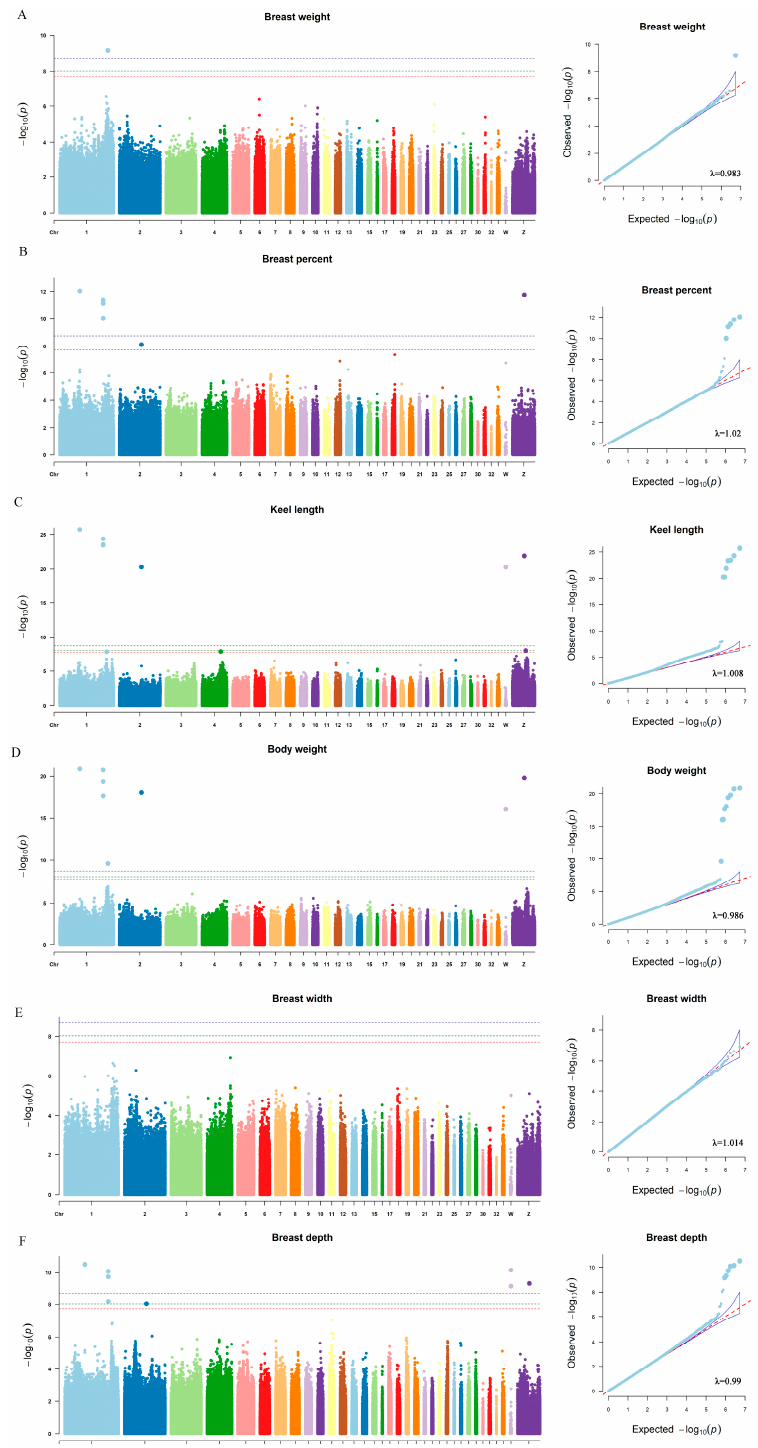
Figure 4. The Manhattan plot and Q–Q plot for breast weight and other traits. In the Manhattan plot, the X axis represents the position of SNPs in chromosome and the Y axis represents the − log 10 ( p -value); The red dashed line represents a 10% genome-wide significance level ( p = 1.79 × 10 − 8 ) after the Bonferroni correction; the green dashed line represents a 5% genome-wide significance level ( p = 8.96 × 10 − 9 ) after the Bonferroni correction; and the blue dashed line represents a 1% genome-wide significance level ( p = 1.79 × 10 − 9 ) after the Bonferroni correction. ( A ) Breast muscle weight; ( B ) Breast muscle percent; ( C ) Keel length; ( D ) Body weight; ( E ) Breast width; ( F ) Breast depth.